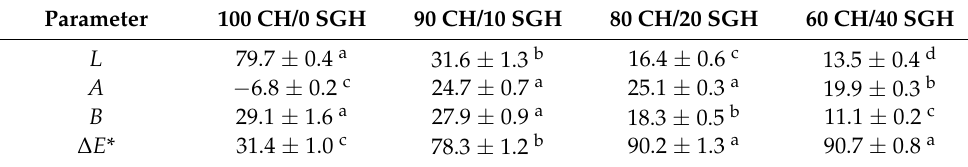
Figure 2. Photograph ( A ) and SEM images of the morphologies of the chitosan (CH) and squid gelatin hydrolysates (SGH) films at 1000× magnification ( B ): ( a ) 100 CH/0 SGH, ( b ) 90 CH/10 SGH, ( c ) 80 CH/20 SGH, and ( d ) 60 CH/40 SGH. Table 1. Color properties 1 of chitosan (CH) with squid gelatin hydrolysate (SGH) films.